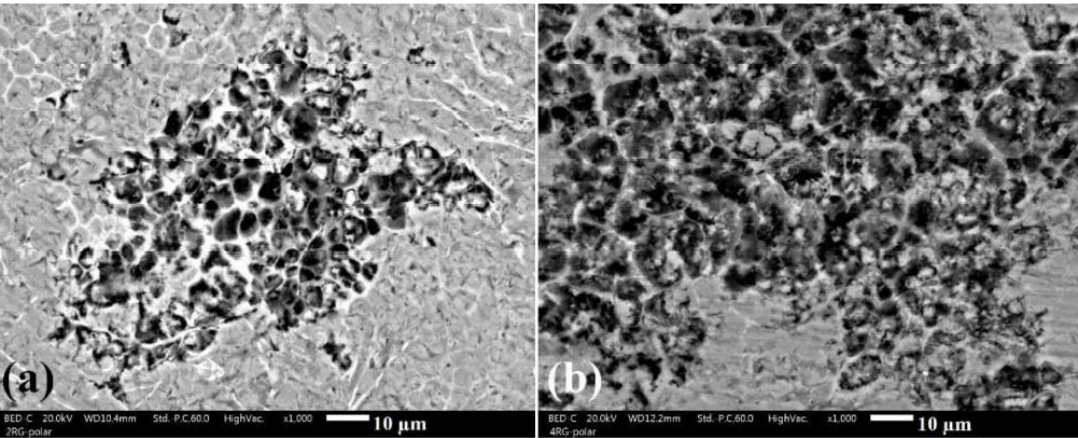
Figure 13. Corroded surfaces of ( a ) 2.5RG and ( b ) 4.5 RG after polarization test in the diluted Harrison solution. Reprinted with permission of [43].